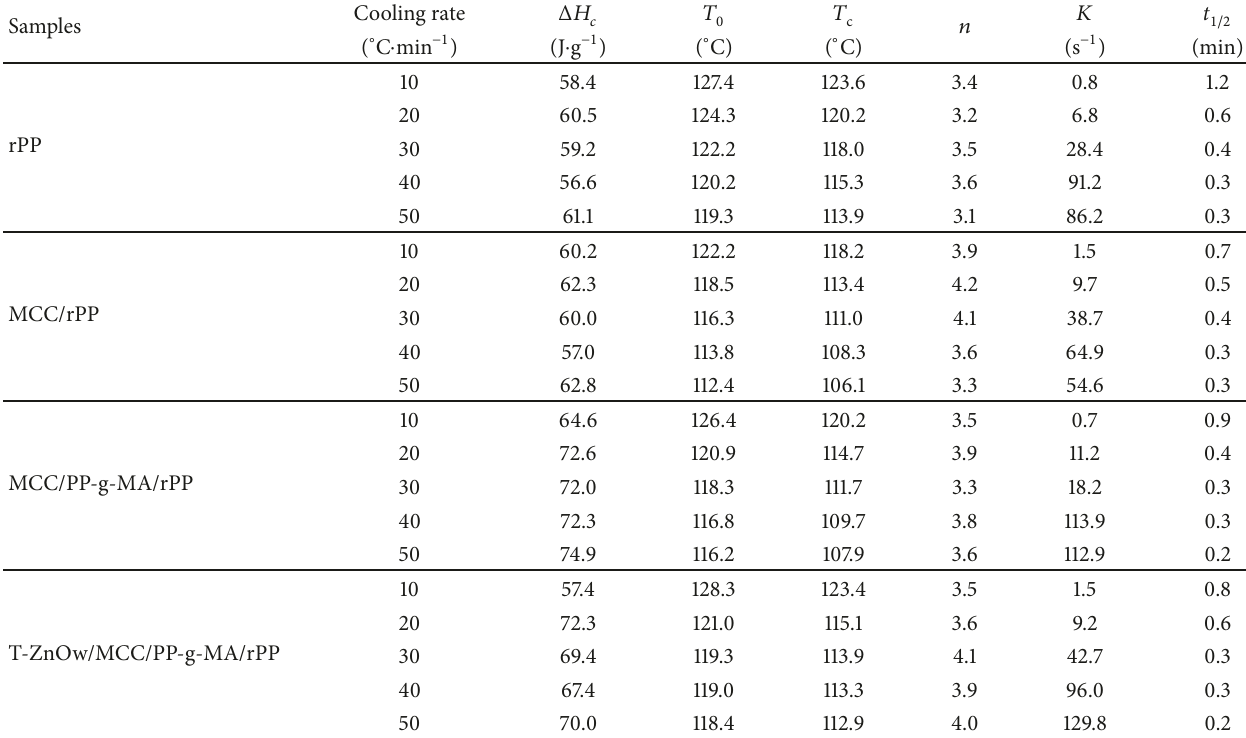
Table 5: Nonisothermal crystallization parameters of pure rPP and rPP based composites.